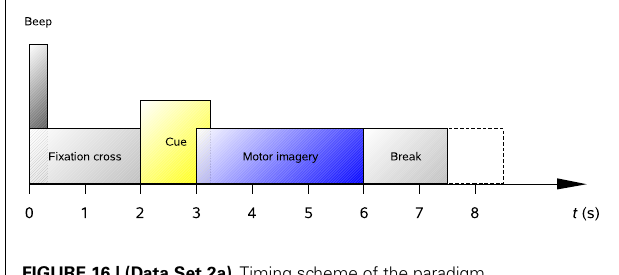
FIGURE 16 | (Data Set 2a). Timing scheme of the